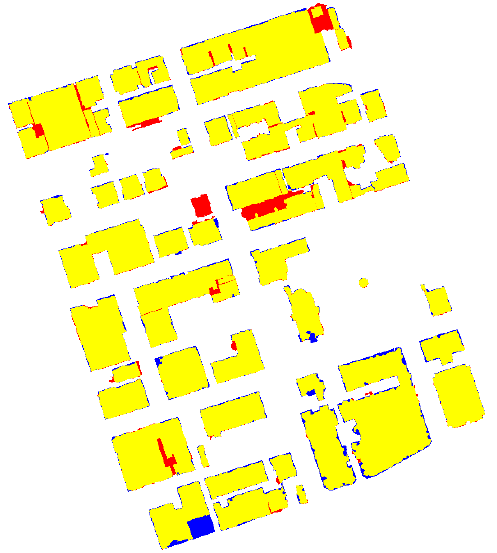
Figure 15. Elevation result provided by ISPRS. Yellow pixels are true positives, red pixels are false positives, and blue pixels are false negatives.